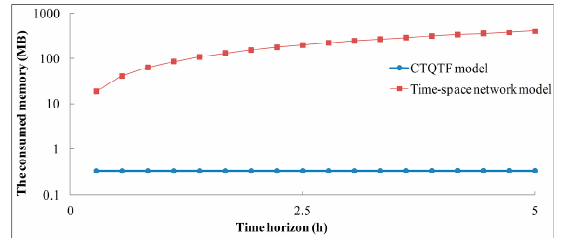
Figure 13. The space performance comparison of solution methodology.